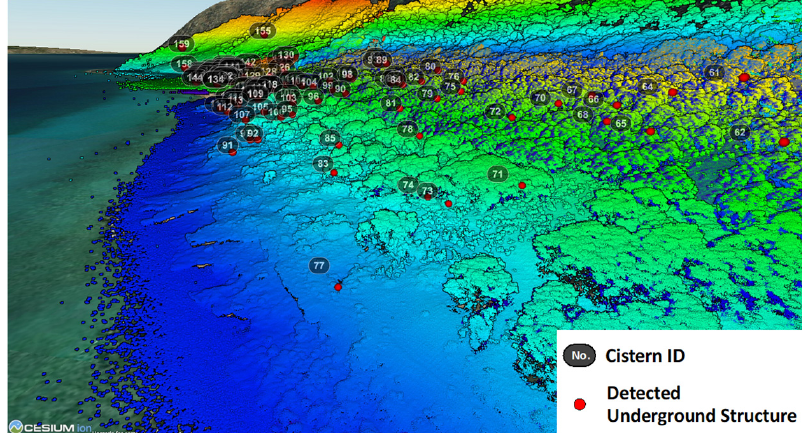
Figure 26. Illustration of the base map and UAV LiDAR point cloud overlaid with annotated detected underground structure locations (red dots).